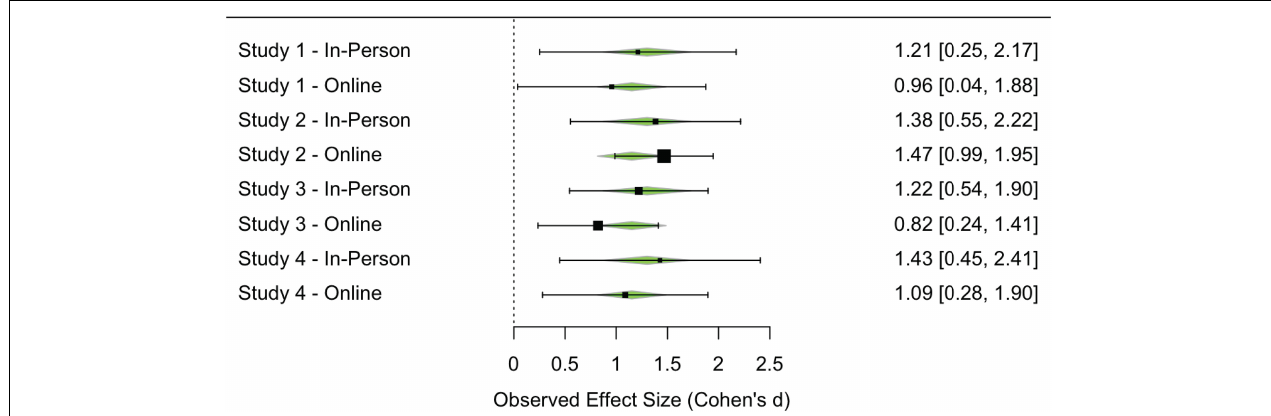
FIGURE 5 | Forest plot showing the standardized effect of interest across Studies 1–4, comparing in-person and online data collection methods. Points are sized based on sample, and error bars indicate effect size variance. Green triangles show random-effects multilevel meta-regression model estimates of the effect size for each